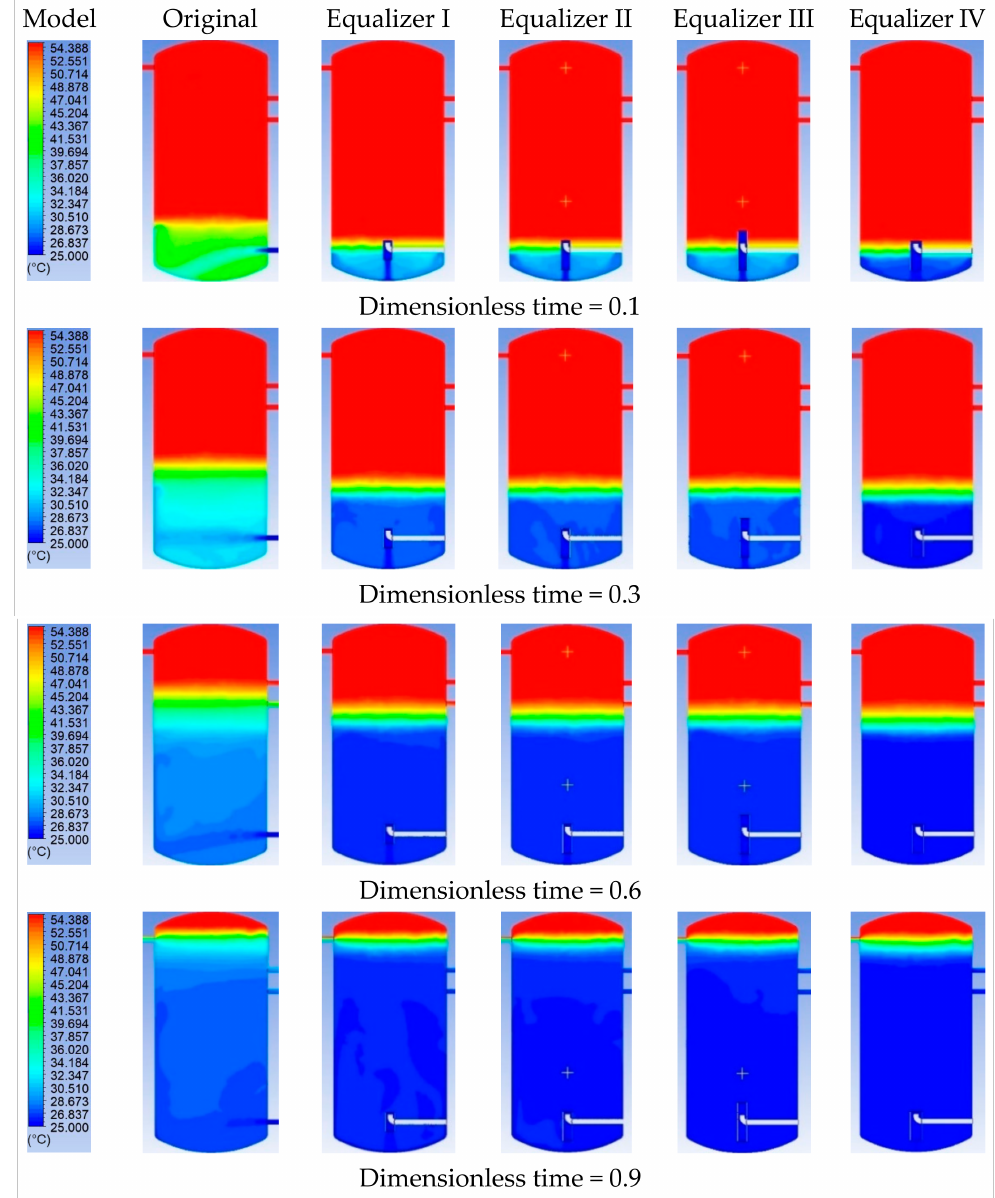
Figure 15. The temperature contours of the equalizer models.